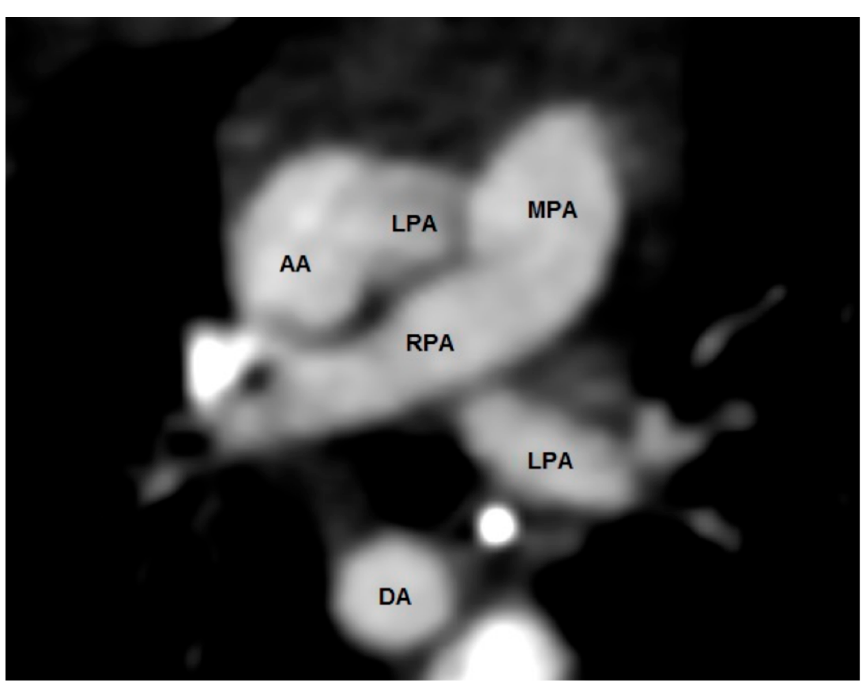
right pulmonary artery.